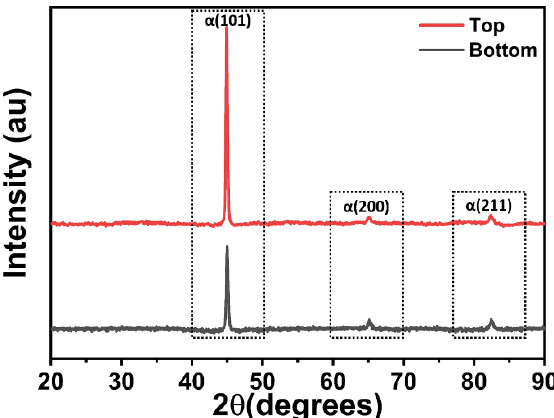
Figure 12. The XRD spectra of bottom and top samples manufactured using the CMT − based WAAM process.